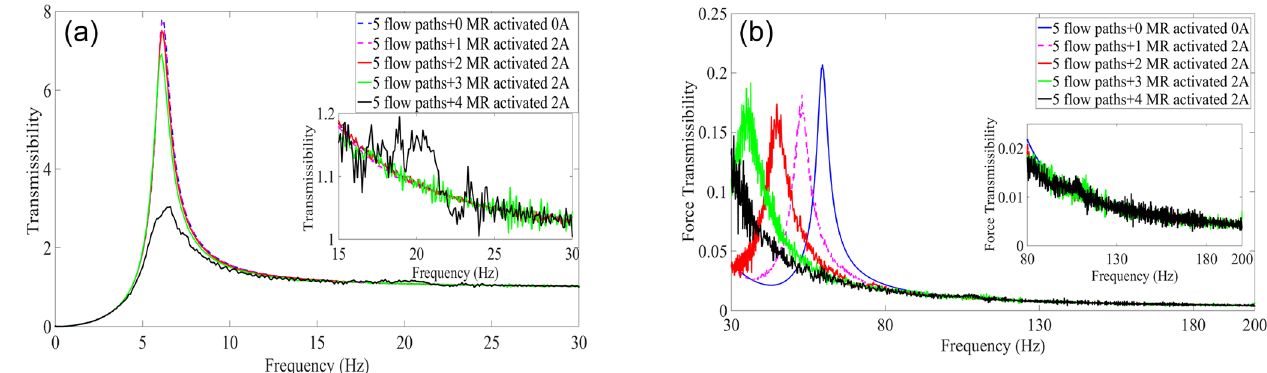
Figure 17. Effect of mount isolation of the 1 / 4 vehicle model: (a) relative displacement transmissibility and (b) force